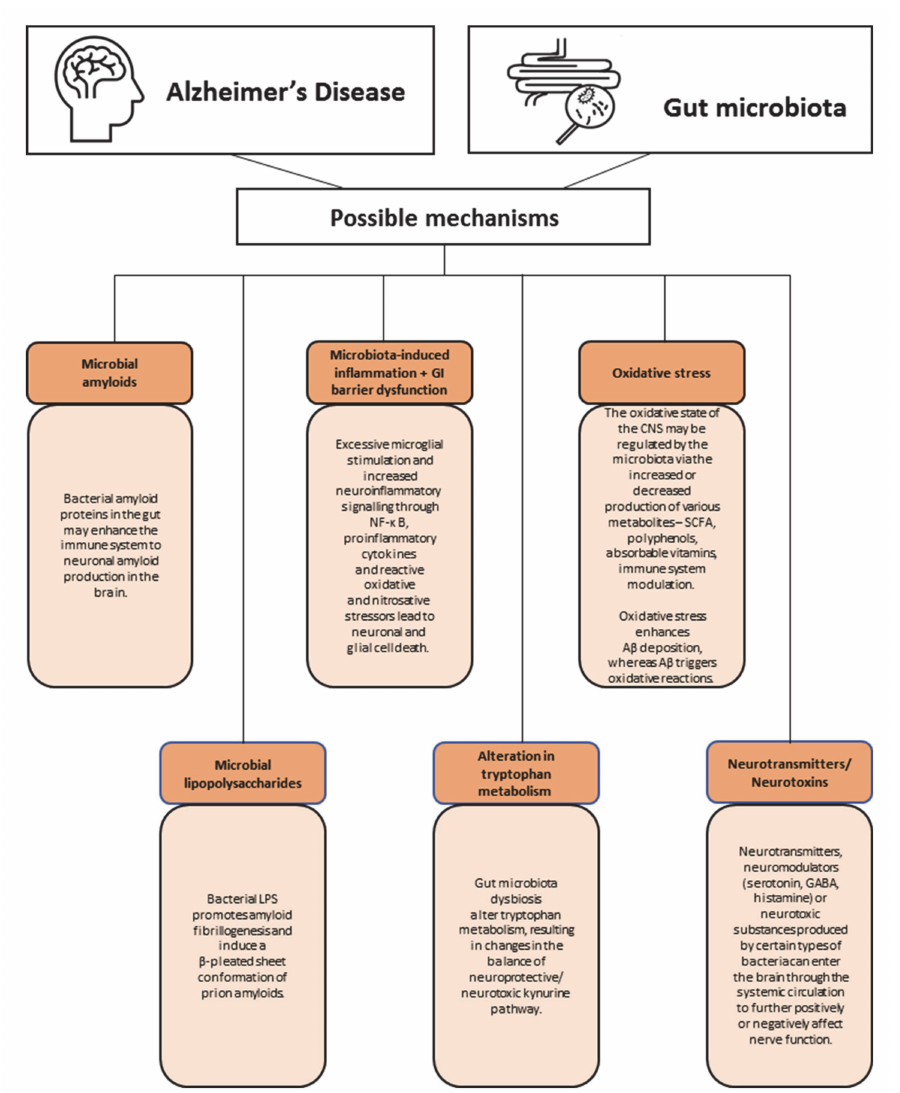
Figure 3. Possible mechanisms behind gut microbiota and Alzheimer’s Disease (AD). Abbreviations: CNS, central nervous system; GABA, γ -aminobutyric acid; SCFA, short-chain fatty